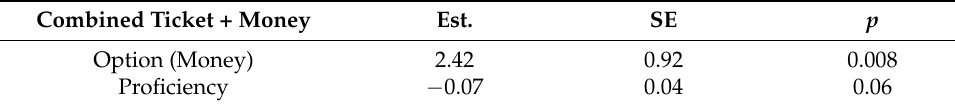
Table 10. Proficiency and framing effects, Spanish task items